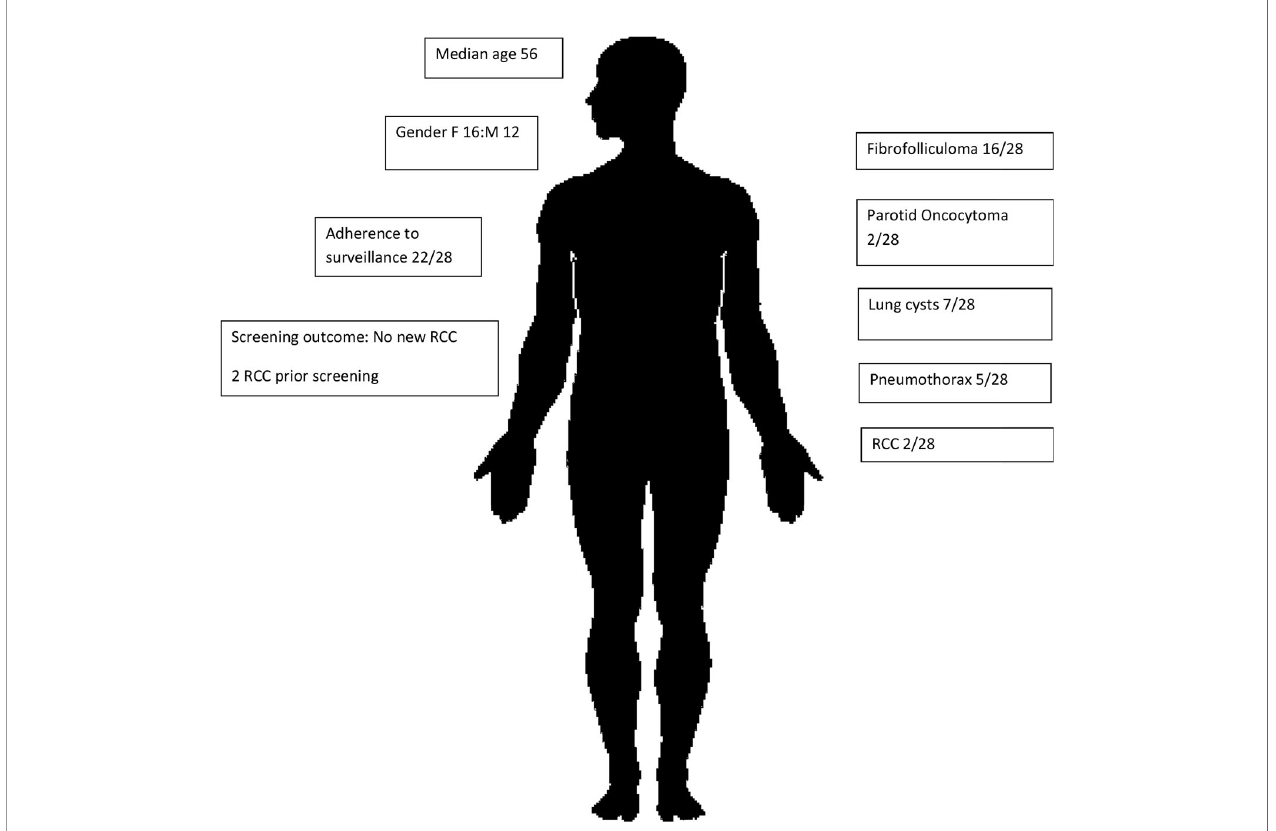
FIGURE 1 | BHD subcohort